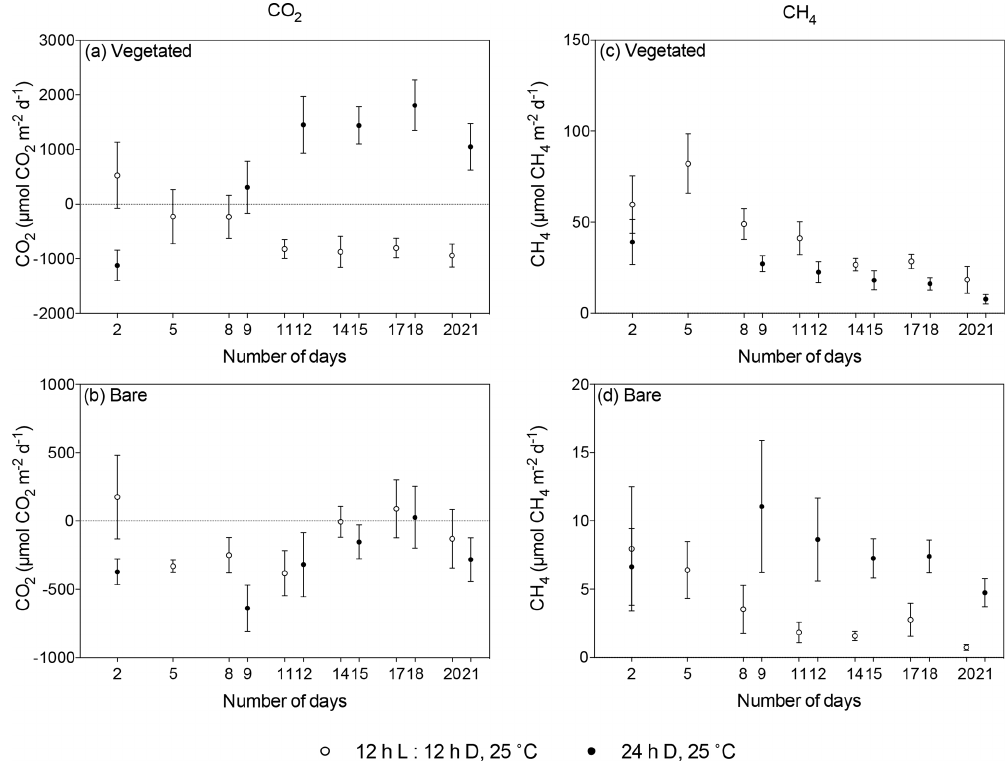
Figure 5. Comparison of mean ± SE CO 2 (left) and CH 4 (right) fluxes in (a, c) vegetated and (b, d) bare sediments maintained at 25 ◦ C with a 12hL:12hD photoperiod (white) and communities kept at 25 ◦ C with a 24 hD period (black) over the experimental period (number of days since the onset of the experiment). Dots indicate mean values, and error bars indicate standard error of the